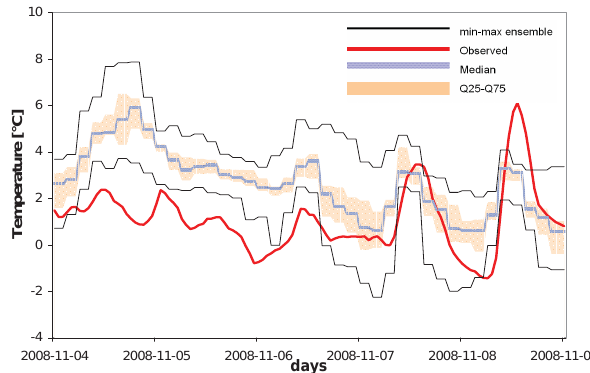
Fig. 6. QDF of the FEST-WB simulation ( S 1 ) forced with observed temperature field and forecasted precipitation by the COSMO- LEPS model (blue line). The red line shows the observed discharge at Candoglia and the green dashed line shows the simulated dis- charge by the FEST-WB ( S 0 ), forced with observed data; the hydro- logical simulation was started on 4 November 2008. The horizontal orange line is the warning codes 2 for the Toce